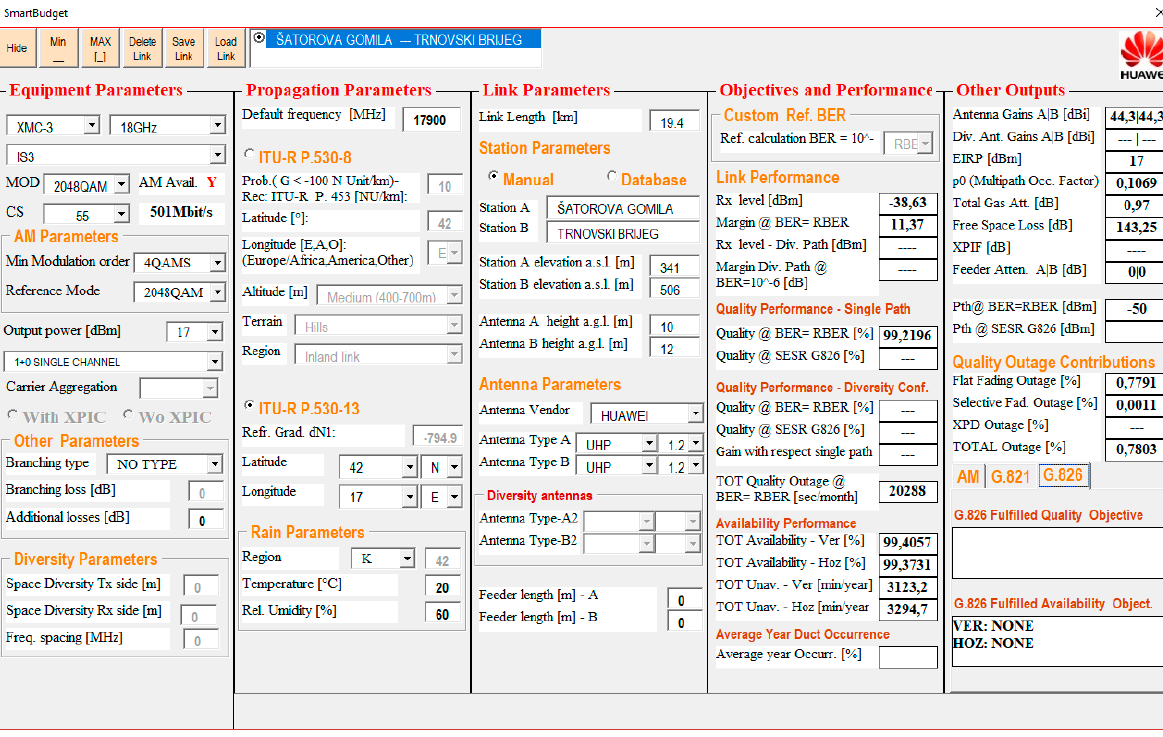
Figure 6. Prediction for the first RR section; 2048 QAM, 500 Mb/s.